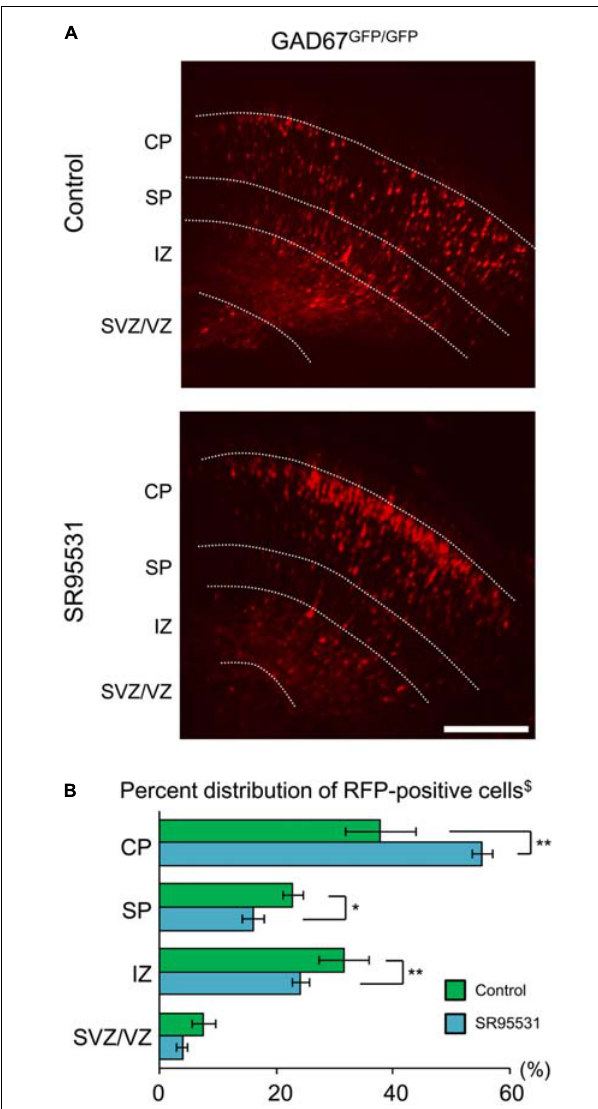
FIGURE 3 | Sustained administration of a GABA A R antagonist facilitates radial migration in GAD67 GFP/GFP fetuses. (A) Photomicrographs showing the distribution of RFP-positive cells in Control (upper) and SR95531-treated (lower) GAD67 GFP / GFP fetuses at E17.5. PLGA with or without SR95531 was injected into the lateral ventricles of GAD67 GFP / GFP fetuses at E14.5, immediately after the electroporation of RFP vectors. (B) Proportions of radially migrating cells in the CP, SP, IZ, and SVZ/VZ.The distribution pattern of RFP-positive cells in SR95531-treated GAD67 GFP / GFP fetuses was significantly different from that in Control, untreated fetuses ( χ 2 -test, $ P < 0.05; Control: n = 6, SR95531-treated: n = 6).The percentage of RFP-positive cells was increased in the CP and decreased in the SP and IZ by SR95531 administration (* P < 0.05, ** P < 0.01). Error bars: mean ± SEM. Scale bar: 200 μ